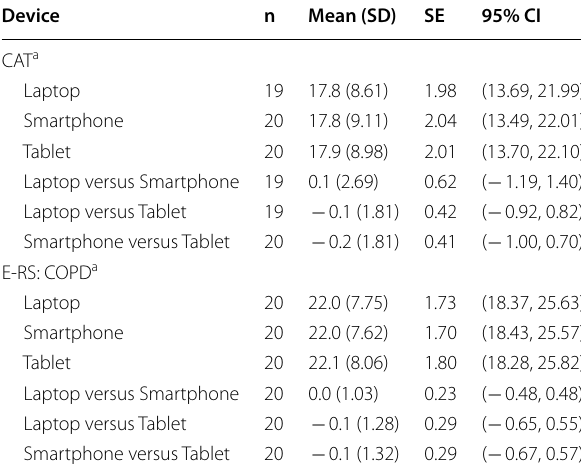
Table 5 Screen size substudy descriptive